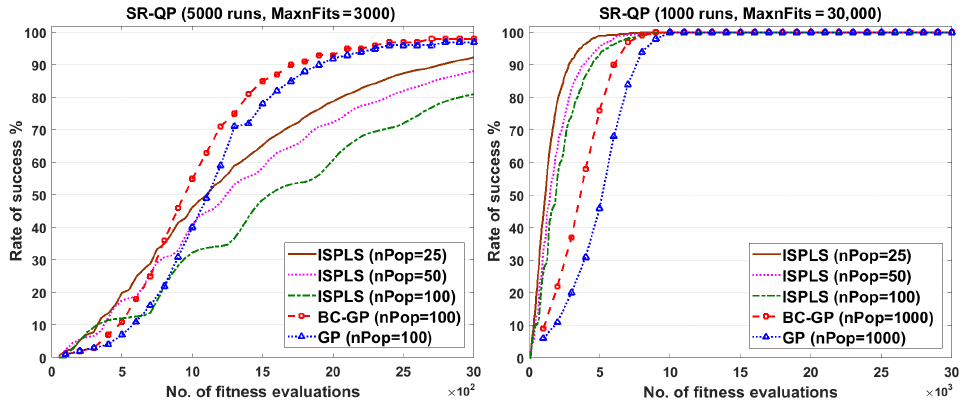
Figure 4. Performance of ISPLS, BC-GP, and GP algorithms for the SR-QP problem.